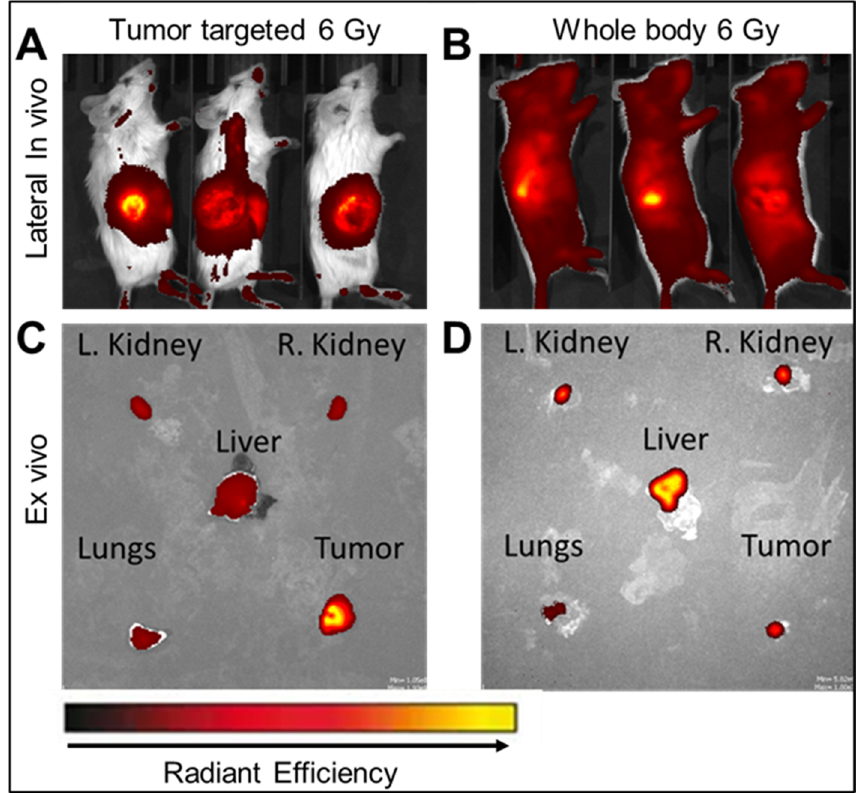
Figure 5 . ICG release from RTLs after tumor-target or whole-body radiation. Representative lateral IVIS images of ICG associated fluorescence 4 h post injection and immediately after ( A ) tumor targeted radiation or ( B ) whole-body radiation. Representative ex vivo IVIS imaging of ICG associated fluorescence in vital organs and tumor at 24 h post ( C ) tumor targeted radiation or ( D ) whole-body radiation. Images representative of n = 6.